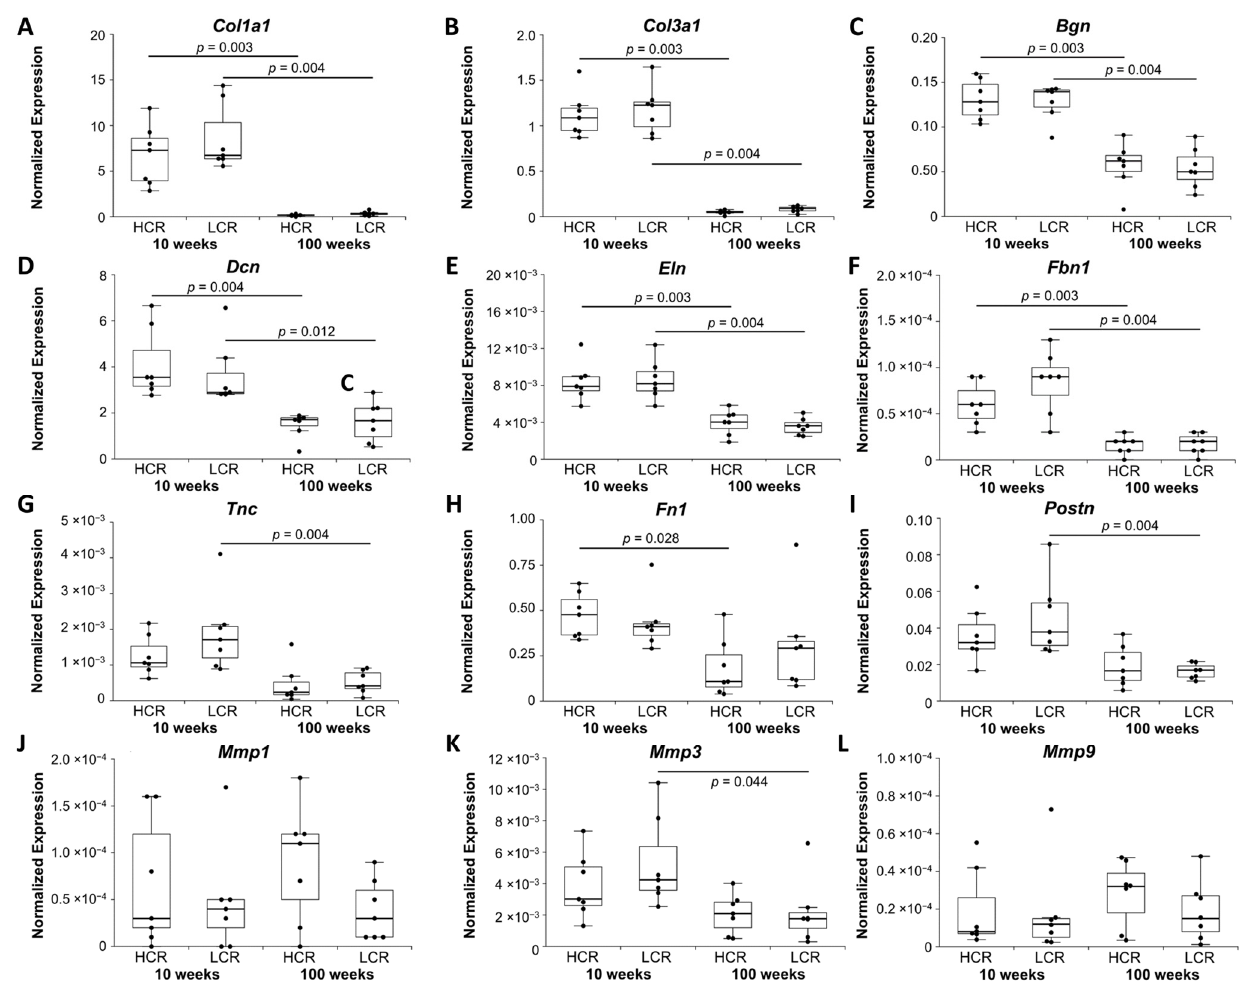
Figure 2. Normalized expression (NE) of tendon-associated ( A , B ) collagens, ( C – I ) other ECM modeling and remodeling genes, and ( J – L ) MMPs. qRT-PCR data were normalized to the expression of the house keeping gene Rps18 . Results are shown as box plots with individual data points. Significant differences between two groups are marked as a line spanning between them with the p -value displayed above. p ≤ 0.05 was considered statistically